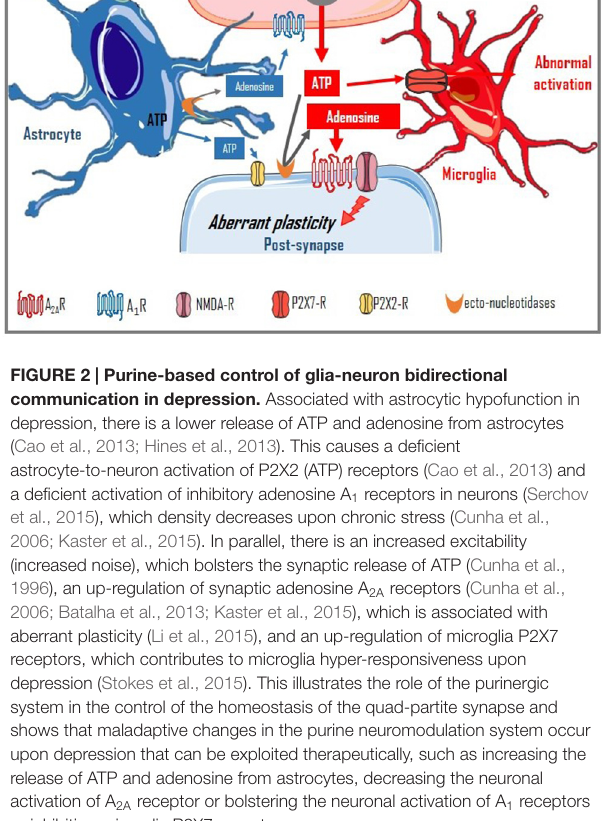
receptors (Fredholm et al., 2005) that act neuronally to control synaptic transmission and plasticity (Cunha, 2008) and also control astrocytic (van Calker and Biber, 2005; Matos et al., 2013, 2015) and microglia function (Rebola et al., 2011; Luongo et al., 2014; George et al.,